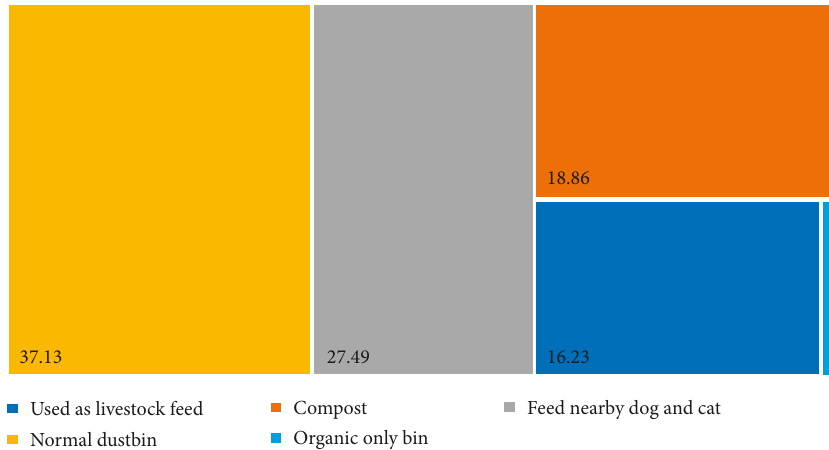
Figure 11: Food waste management claimed by respondents.